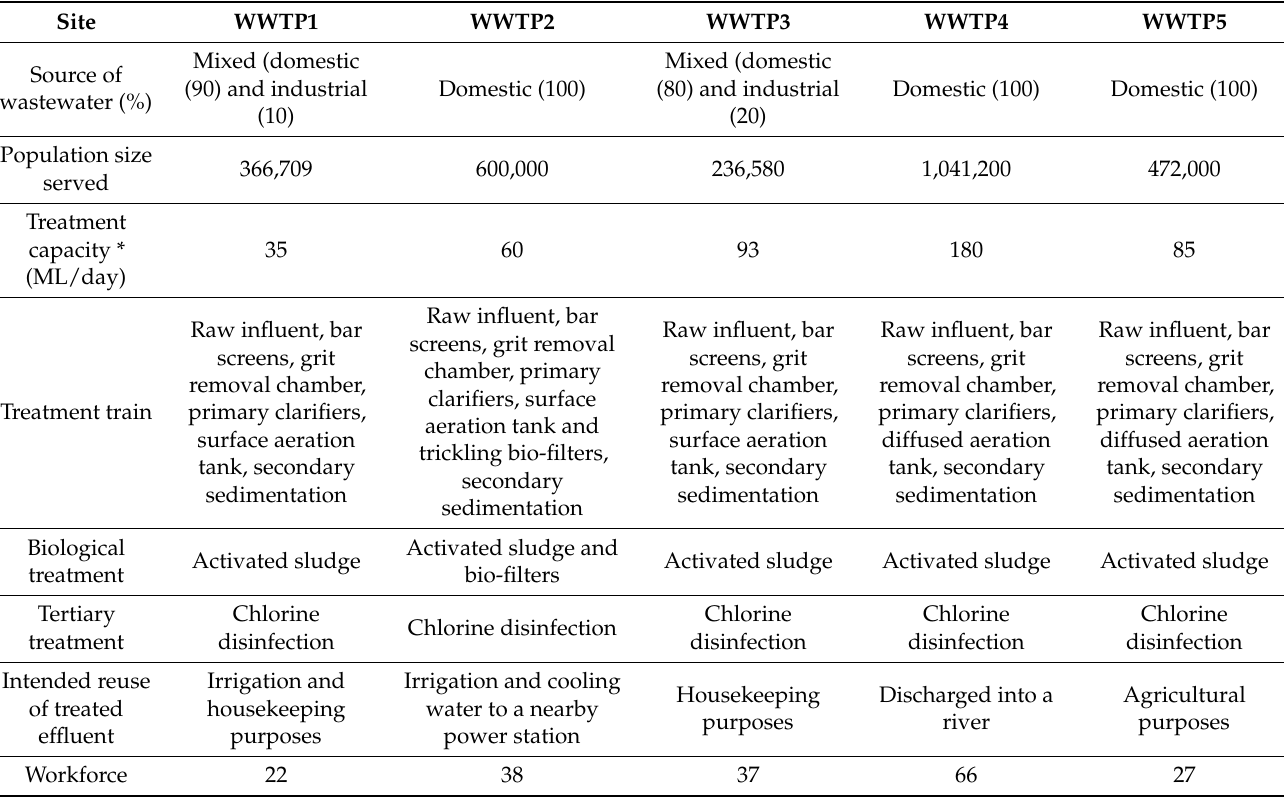
Table 1. Characteristics of WWTP sampling